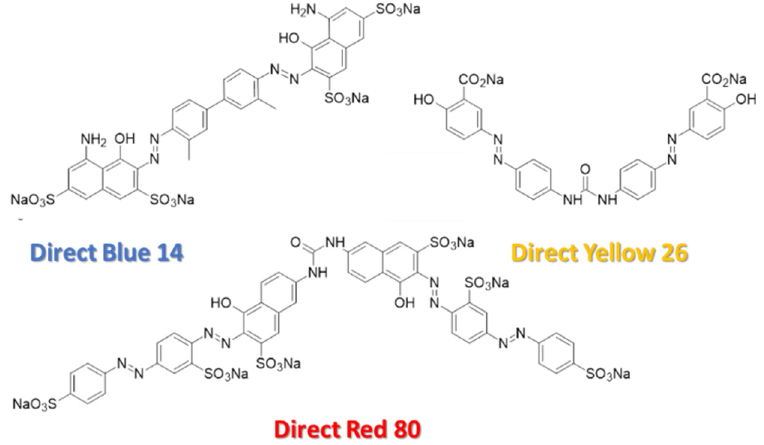
Figure 1. The chemical structure of the direct red 80, direct blue 14, and direct yellow 26, obtained from the ChemDraw database (PerkinElmer, Inc., Waltham, MA, USA).